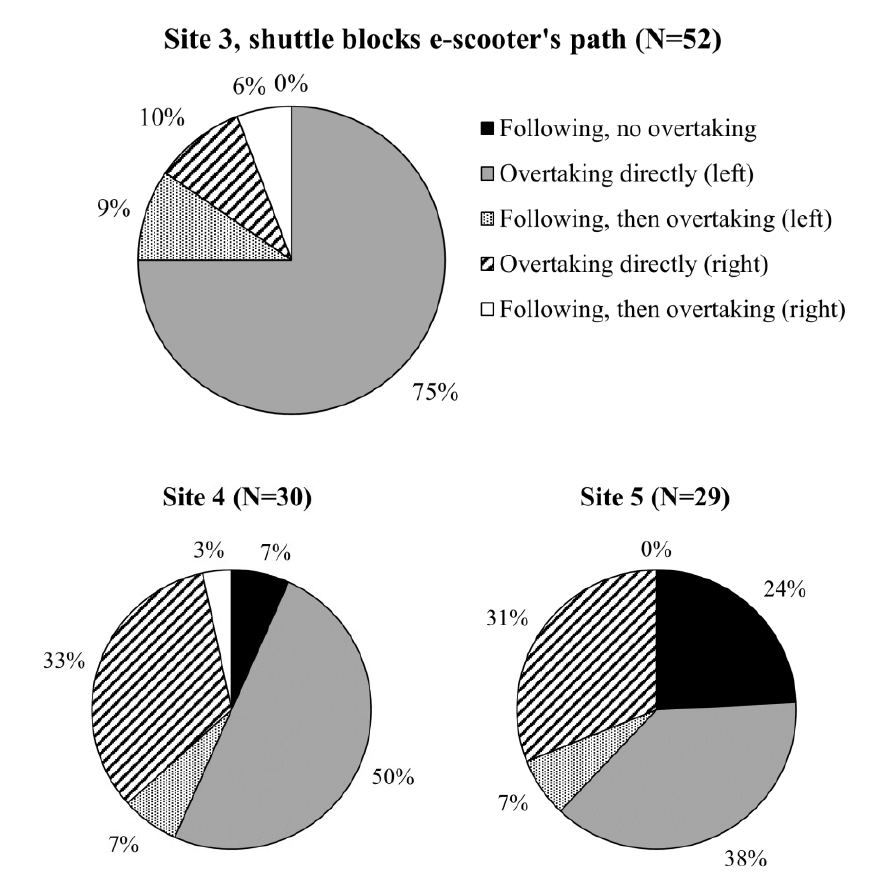
Figure 6 Same direction interactions between e-scooter riders and automated